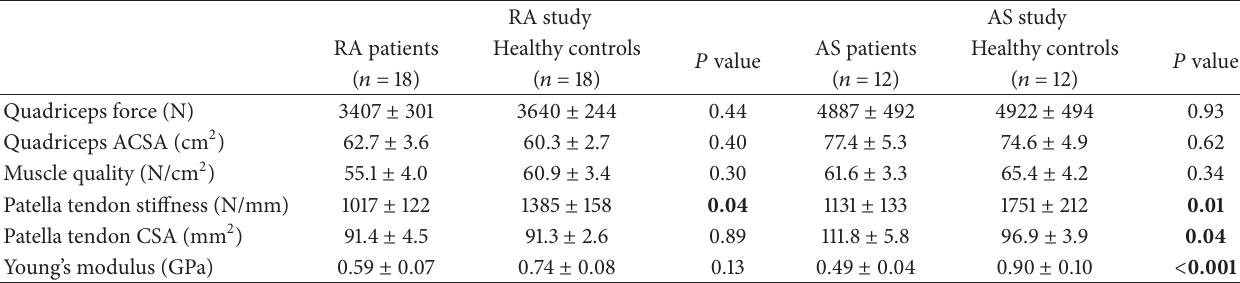
Table 3: Physiological data of RA ( 𝑛 = 18 ; 13 women) and AS ( 𝑛 = 12 ; 4 women) patients versus age- and sex-matched healthy controls. ACSA: anatomical cross-sectional area. Results are presented as mean ±